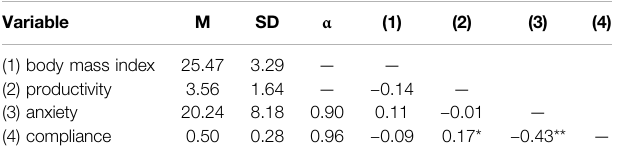
TABLE 2 | Means, standard deviation, reliability coef fi cients, and